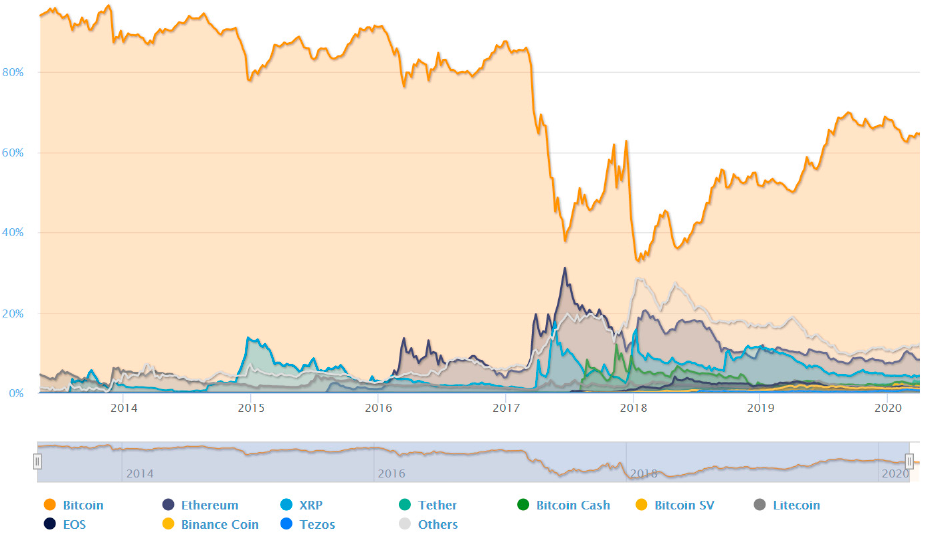
// ru.investing.com / crypto /